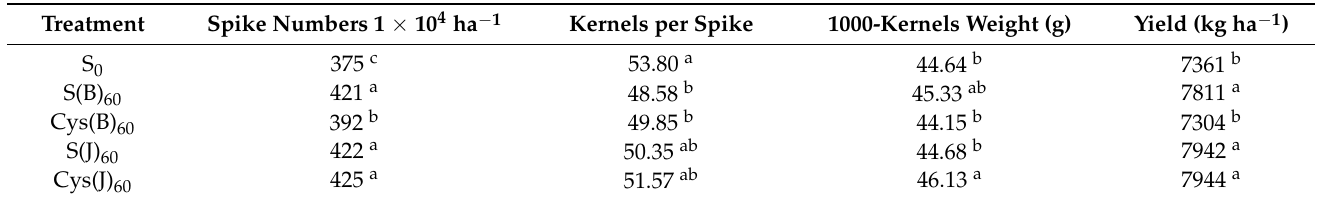
Effects of cysteine and inorganic sulfur application at different stages on wheat yield